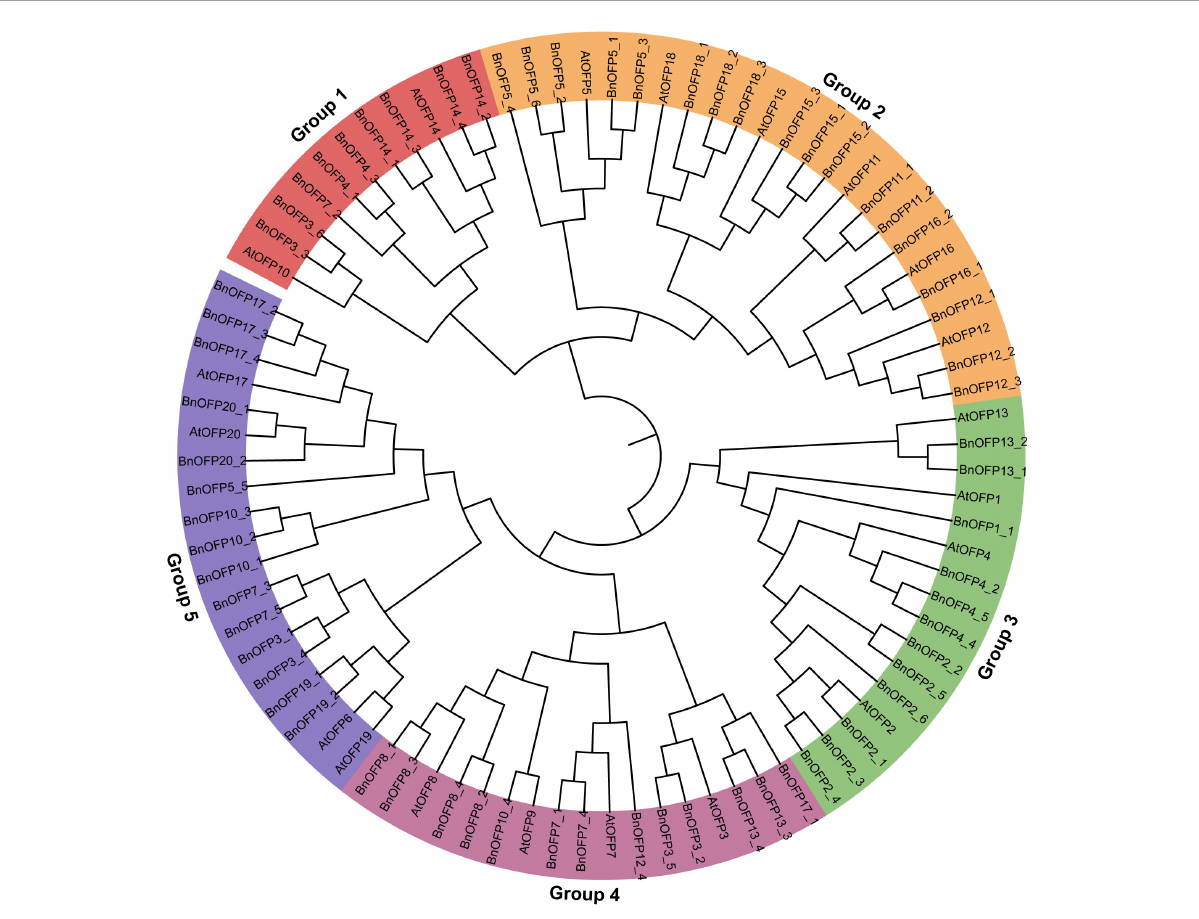
FIGURE2 Phylogenetic relationship analysis of ovate family proteins (OFPs) in Arabidopsis and Brassica napus . The 20 AtOFP genes and 67 BnOFP genes were clustered into five groups. Members of each group were represented by different background